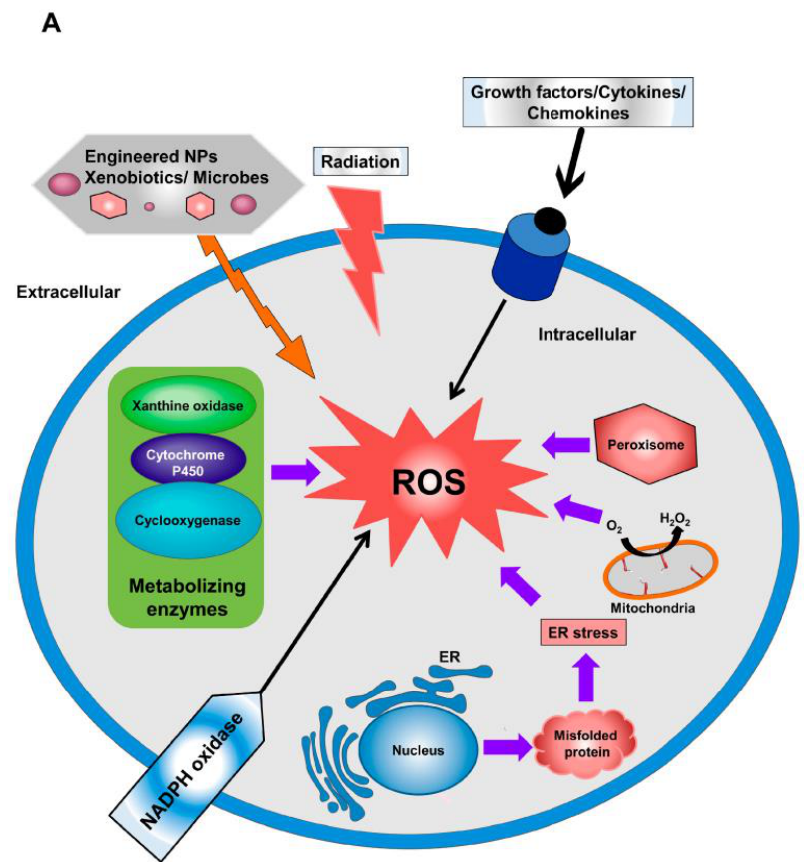
Figure 2. Some major intracellular (mitochondria, peroxisome, endoplasmic reticulum (ER) stress, nicotinamide adenine dinucleotide phosphate hydrogen (NADPH) oxidase, metabolizing enzymes) and extracellular (Radiations, Xenobiotics) sources of reactive oxygen species (ROS) generation [81].